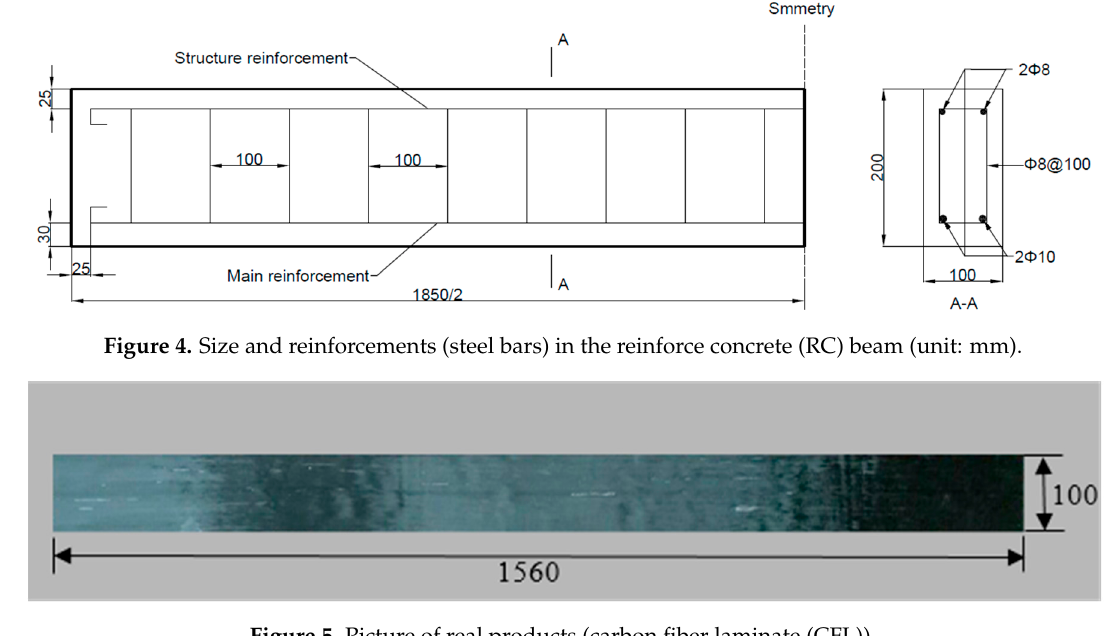
Figure 5. Picture of real products (carbon fiber laminate (CFL)).